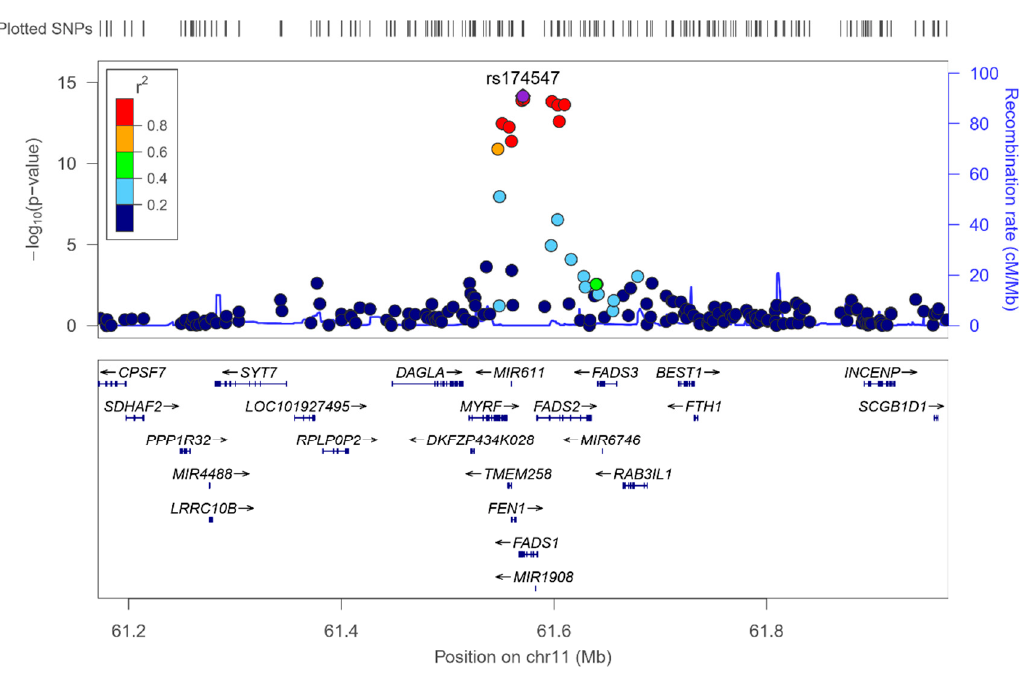
Figure 2. Regional plot for the top-ranked SNP rs174547 for serum omega-3 fatty acid, located in the FADS1 gene, on chromosome 11. Results in the whole population.